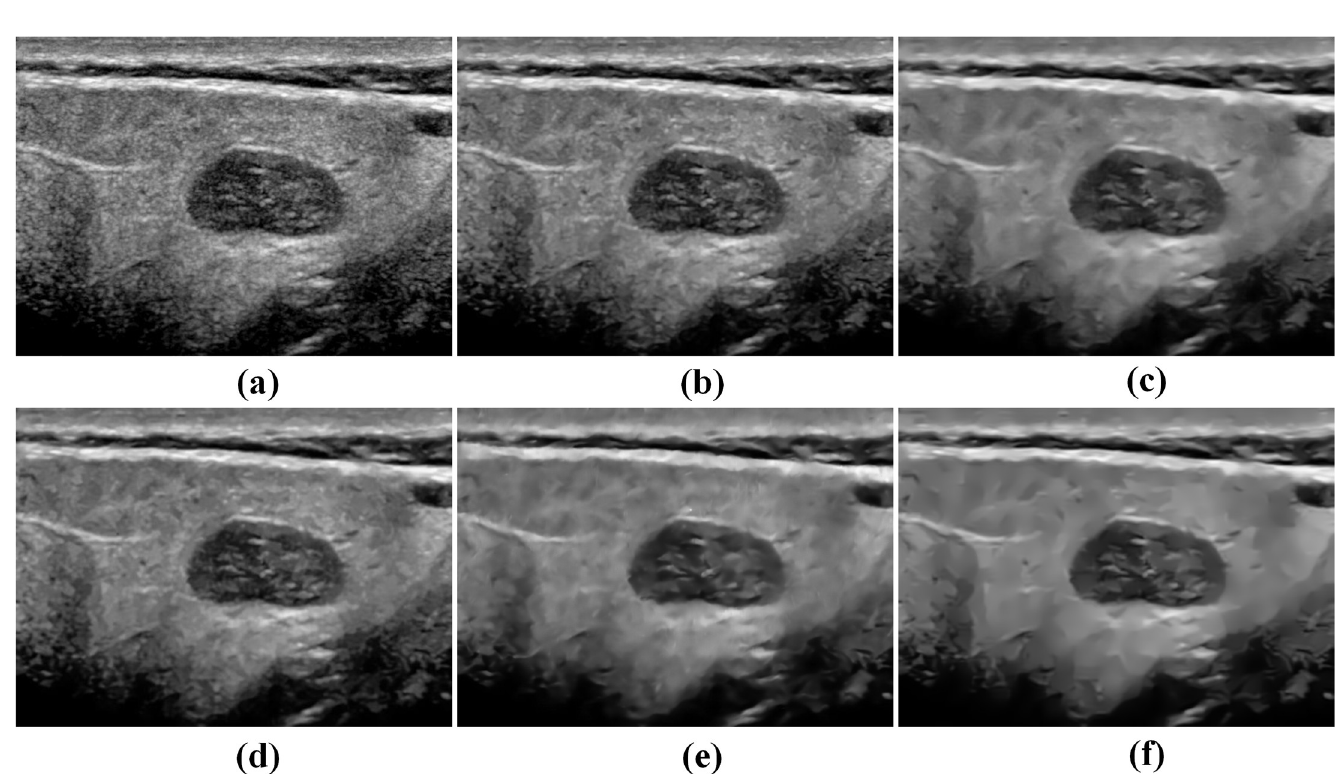
Fig 10. Comparison of restoration performance on a real parotid gland adenoma ultrasound image for the NLM-based and DnCNN methods. (a) original image, (b) TNLM filter, (c) OBNLM filter, (d) NLMLS filter, (e) DnCNN filter, and (f) PPCA-NLM filter.